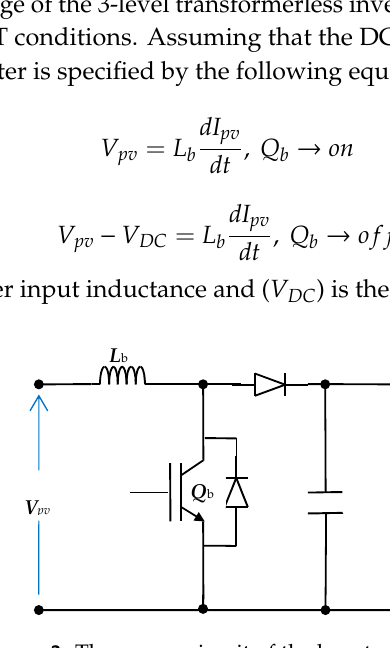
Figure 2. Model of the PV panel, where I SC is the panel short circuit current and ( R p , R s ) is the model parallel and series resistances.